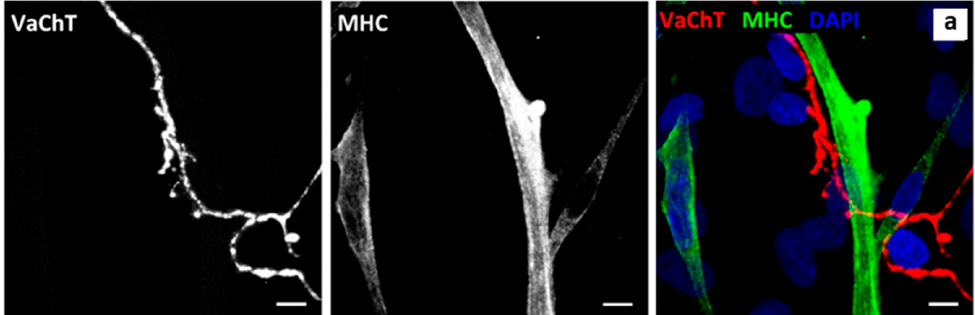
Figure 2. Cholinergic motor neurons co-localise with myotubes at Day 14. Panel a is a representative image of co-culture stained for vesicular acetylcholine transporter (VaChT) (red), myosin heavy chain (MHC) (green) and DAPI (blue). Scale bar = 7.5 µm.